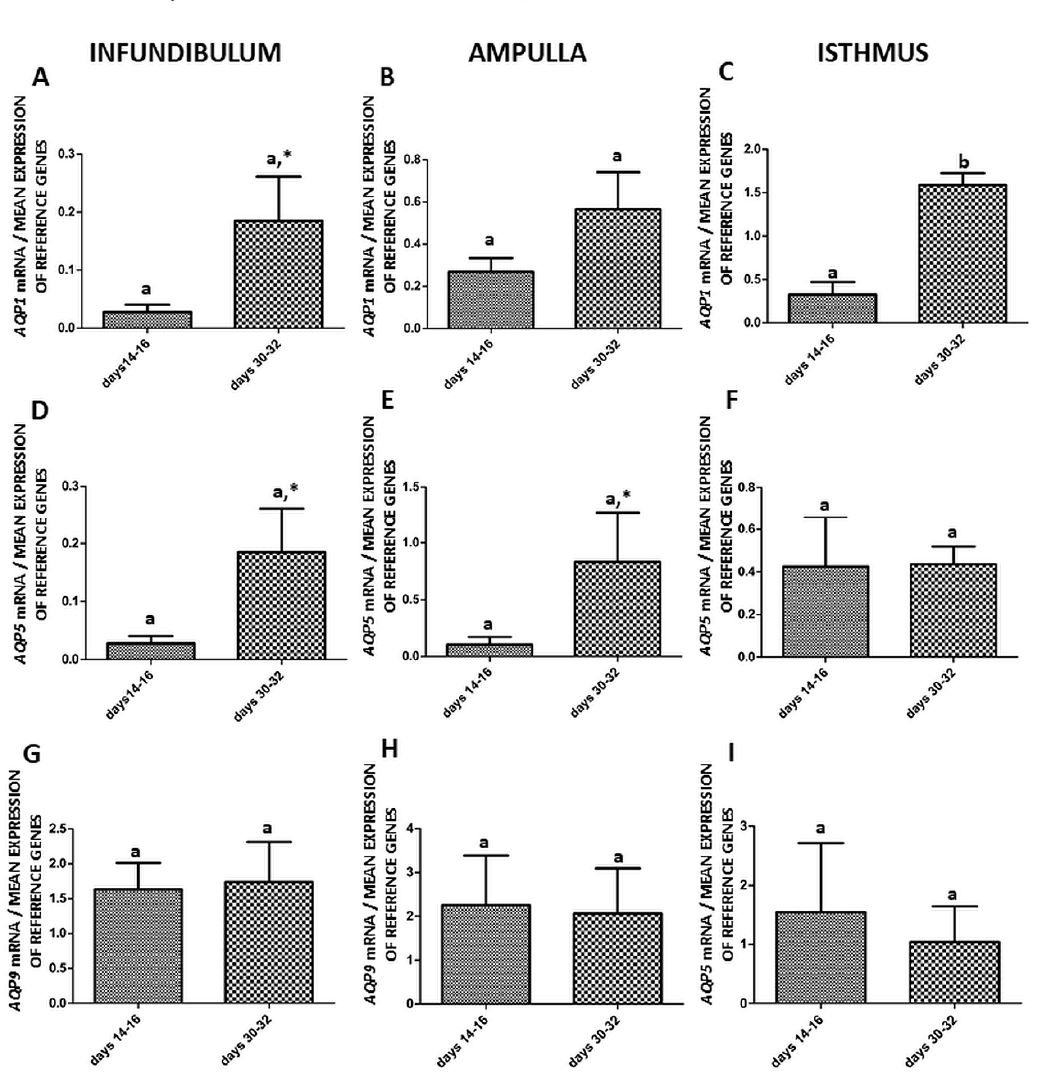
Figure 2. The expression patterns of Aquaporin 1 ( A – C ), Aquaporin 5 ( D – F ), and Aquaporin 9 ( G – I ), genes in porcine oviduct separated into infundibulum, ampulla and isthmus from early pregnancy (days 14–16 and 30–32). The samples were subjected to qPCR analysis and normalized to the geometric mean of 18S RNA and PPIA expression. Each of the graphs marked with a capital letter indicates a specific part of the oviduct. Values are expressed as means ± S.E.M from five individuals, each performed in triplicate ( p < 0.05) ( n = 5). Statistically significant di ff erences between the part of the oviduct to day of the estrous cycle are indicated by di ff erent letters (a, b) and trends ( p < 0.1) by *.